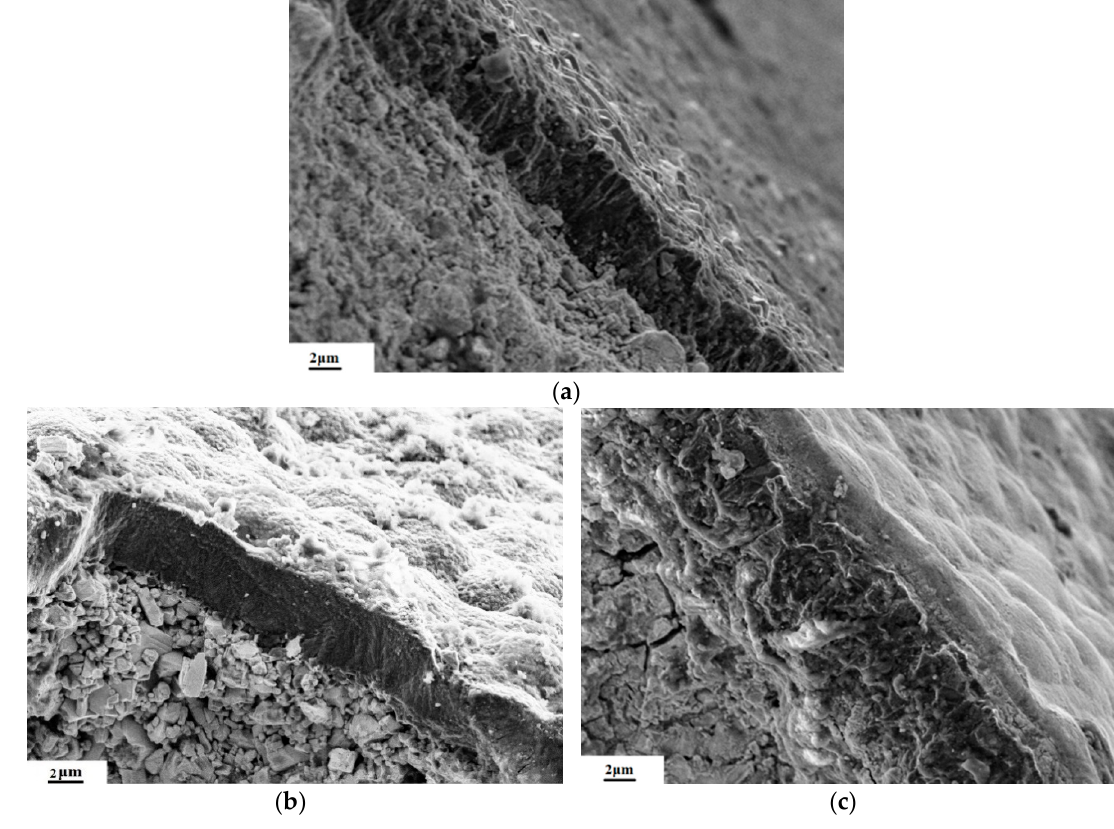
Figure 4. Cross-sectional morphology of diamond coated tools. ( a ) MCD; ( b ) NCD; ( c ) MCD/NCD.